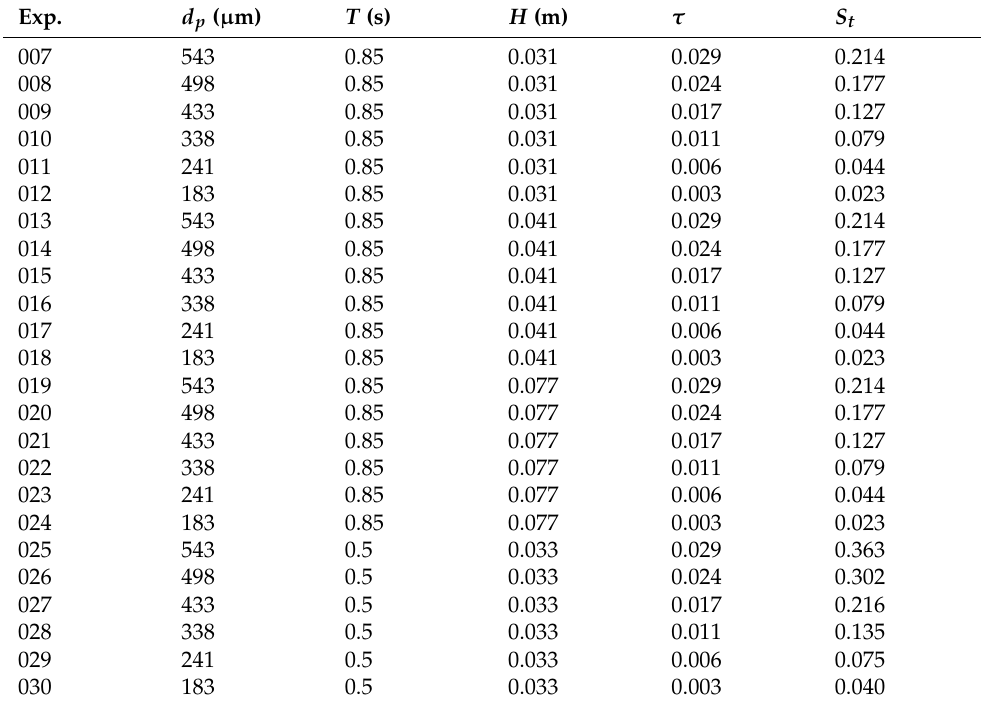
Table 3. Experimental wave and particle